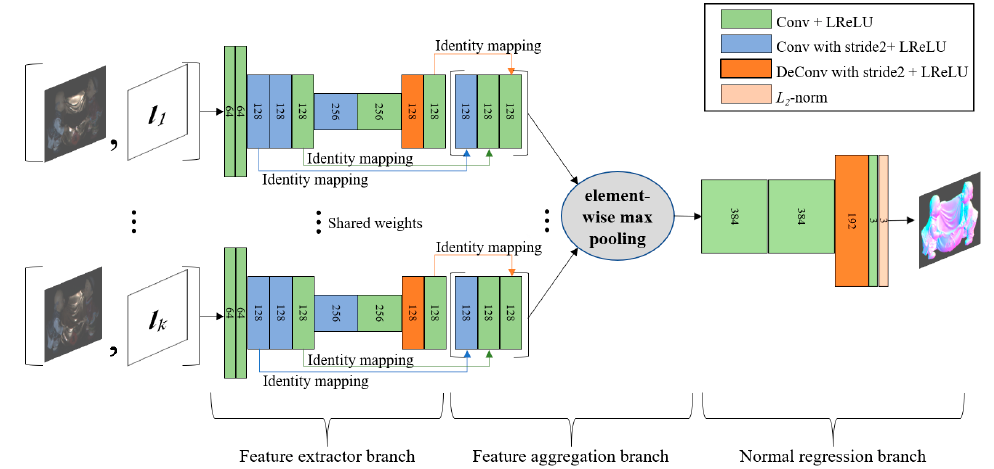
Figure 1. Network architecture for calibrated photometric stereo. The numbers in layers depict the number of output channels.